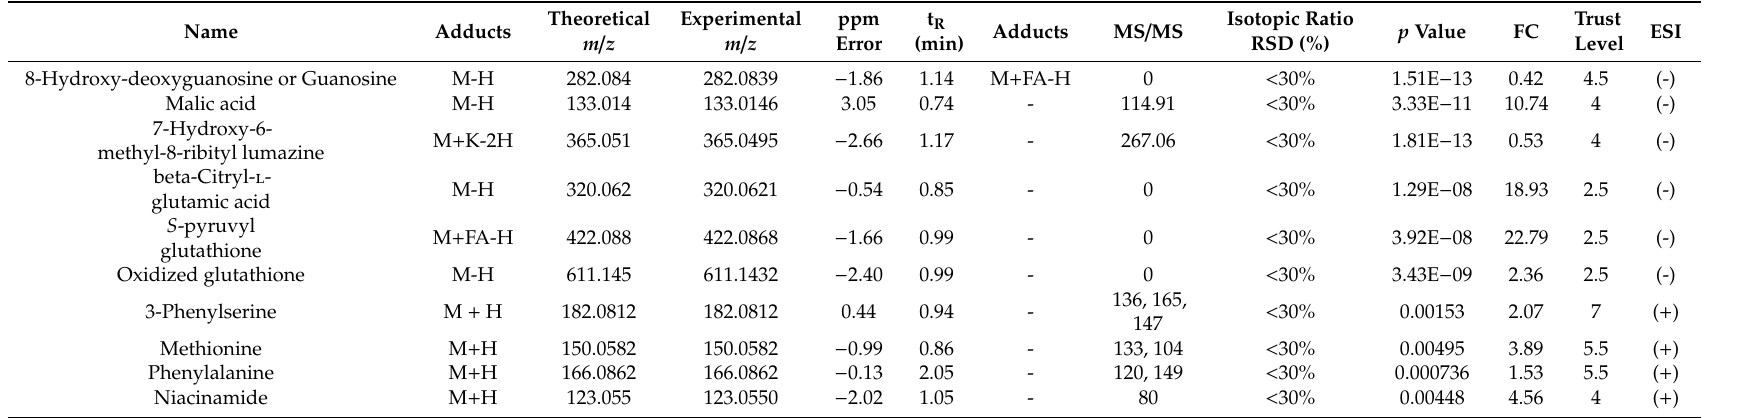
Table 3. Selected 1 melanoma metabolites, together with their corresponding detected parent ions, adducts and MS / MS fragments, theoretical and experimental m /